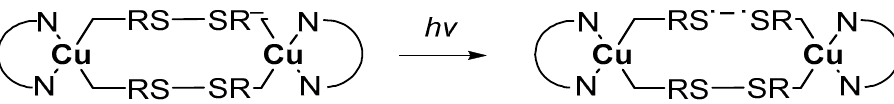
Table 4. List of structurally characterized coordination compounds of copper with fumaric acid and N donor ligands.